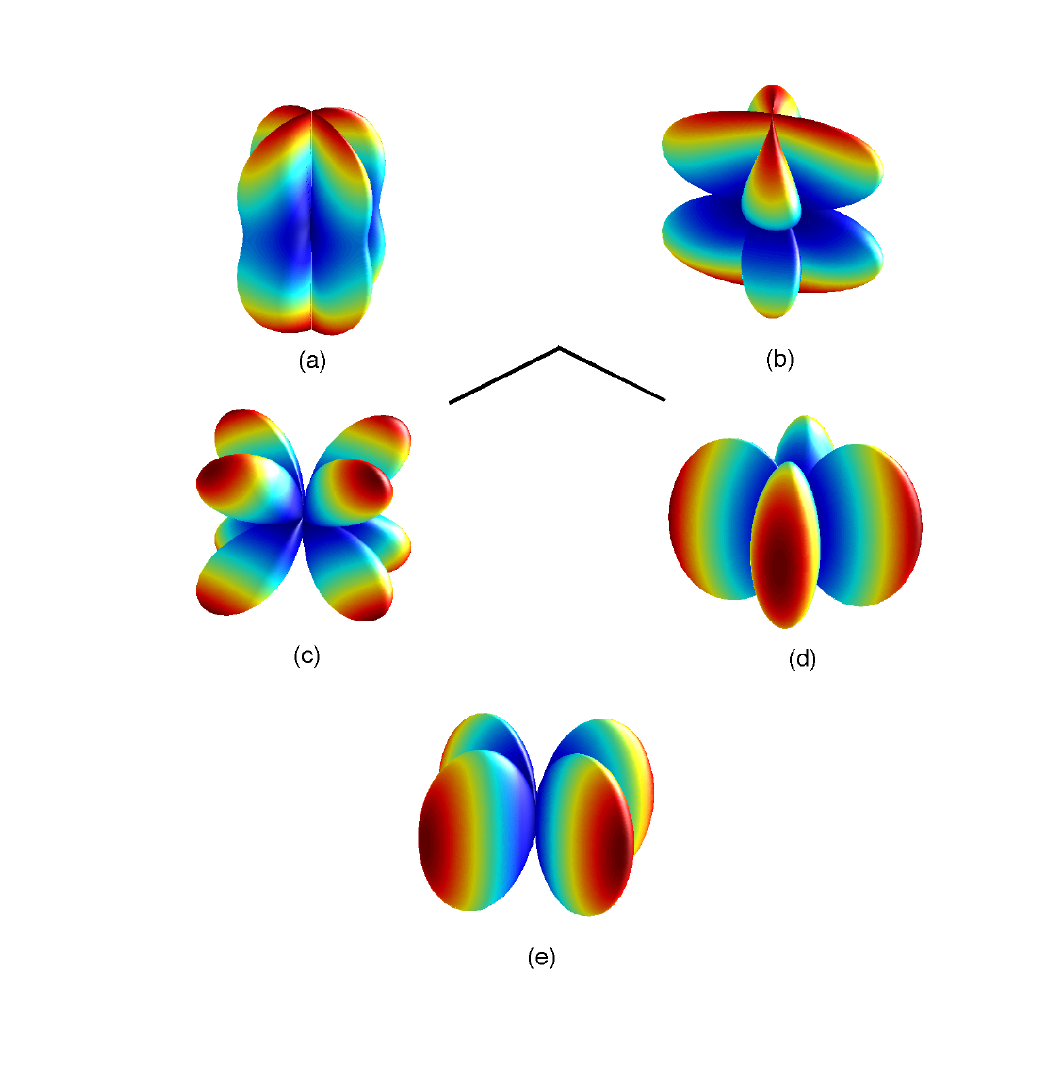
Figure 2: Antenna pattern response functions of an interferometer (see Eqs. (58)) for 𝜓 = 0. Panels (a) and (b) show the plus ( | 𝐹 + | ) and cross ( | 𝐹 × | ) modes, panels (c) and (d) the vector x and vector y modes ( | 𝐹 𝑥 | and | 𝐹 𝑦 | ), and panel (e) shows the scalar modes (up to a sign, it is the same for both breathing and longitudinal). Color indicates the strength of the response with red being the strongest and blue being the weakest. The black lines near the center give the orientation of the interferometer